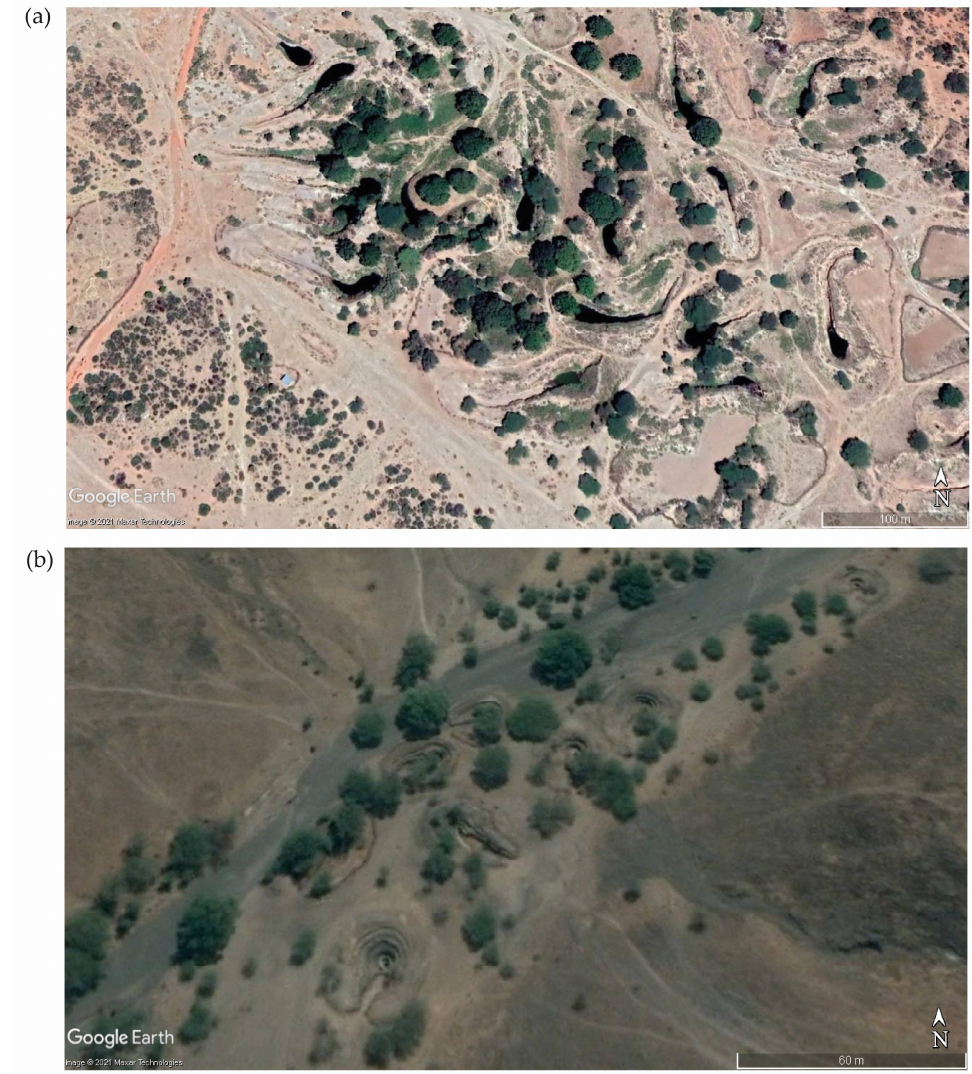
Figure 2. Google Earth imagery of Ethiopian and Kenyan well clusters ( a ) Dubluq tula well cluster 15 December 2020, ( b ) El Hadi well cluster 5 July